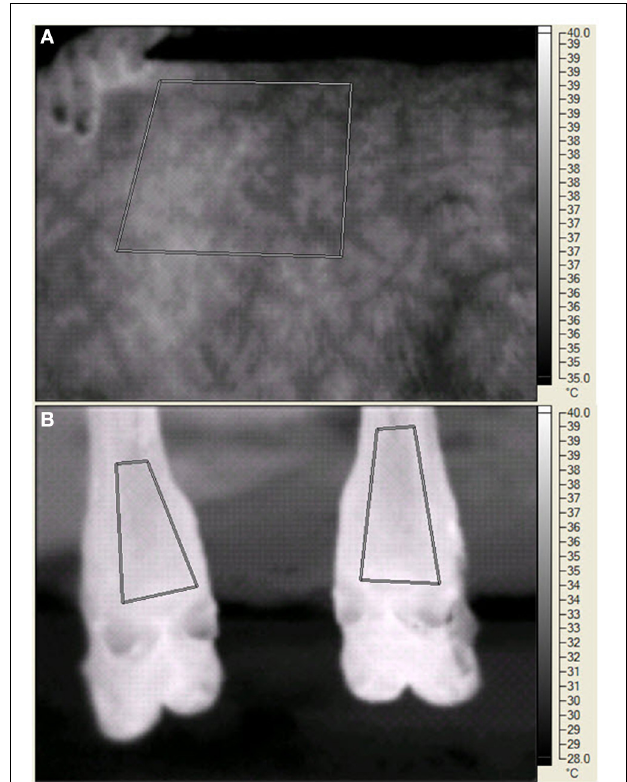
FIGURE 1 | Digital infrared images of the left side (A) and the plantar surface in the area of the large metatarsal bone in the rear legs (B) of a steer during the experiment. The human fingers (A) indicate the edge of the scapula. The paralumbar fossa is to the right of the measured area. For both panels, the geometric shapes indicate areas in which temperature data were recorded. The vertical bar on the far right side of each panel indicates the temperature range ( ◦ C) and the associated light (warmer) to dark (cooler) gradient within the